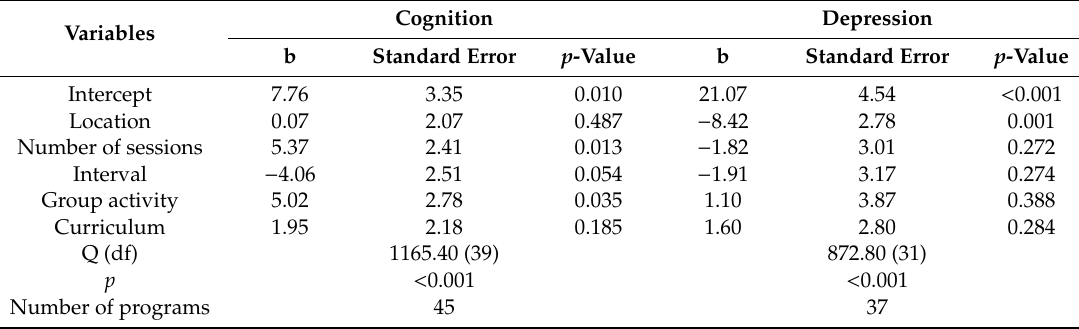
Table 2. The meta-regression analysis results on cognition and